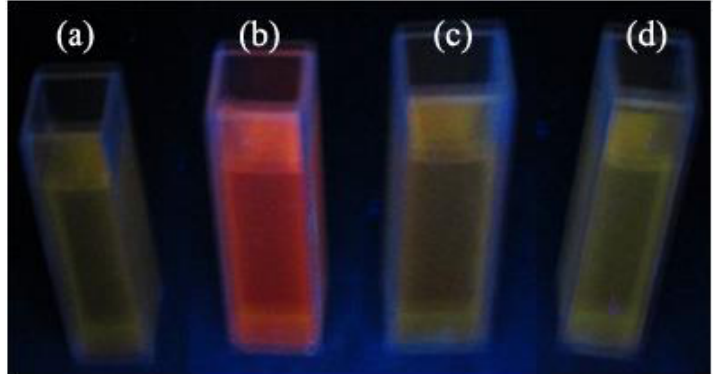
Figure 6. The fluorescence images of the CNF/CdS nanocomposites under different maturing time; ( a ) 40 min; ( b ) 60 min; ( c ) 80 min; and ( d ) 100 min.